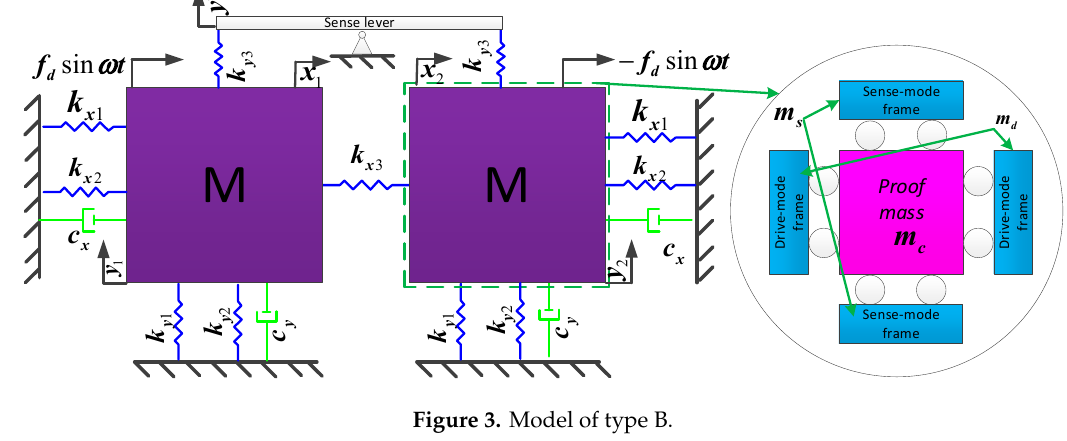
Figure 3. Model of type B.